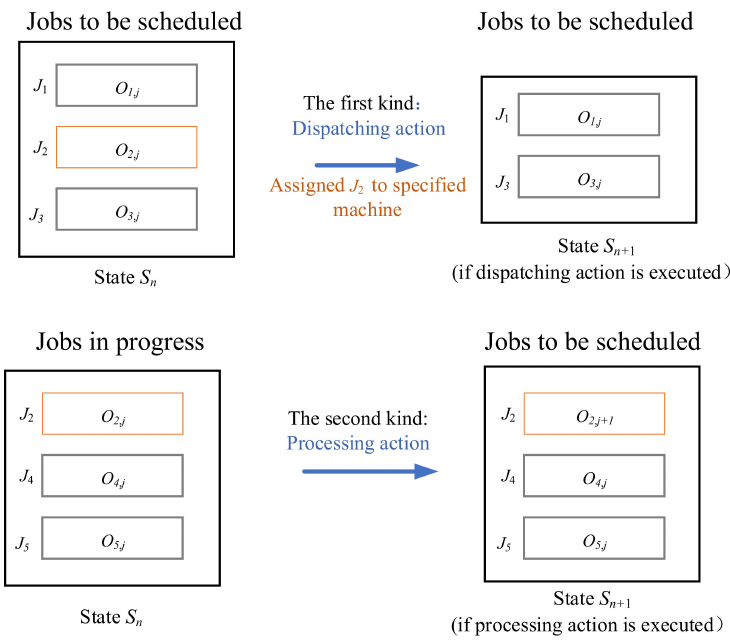
Figure 5. The state transition of the job.